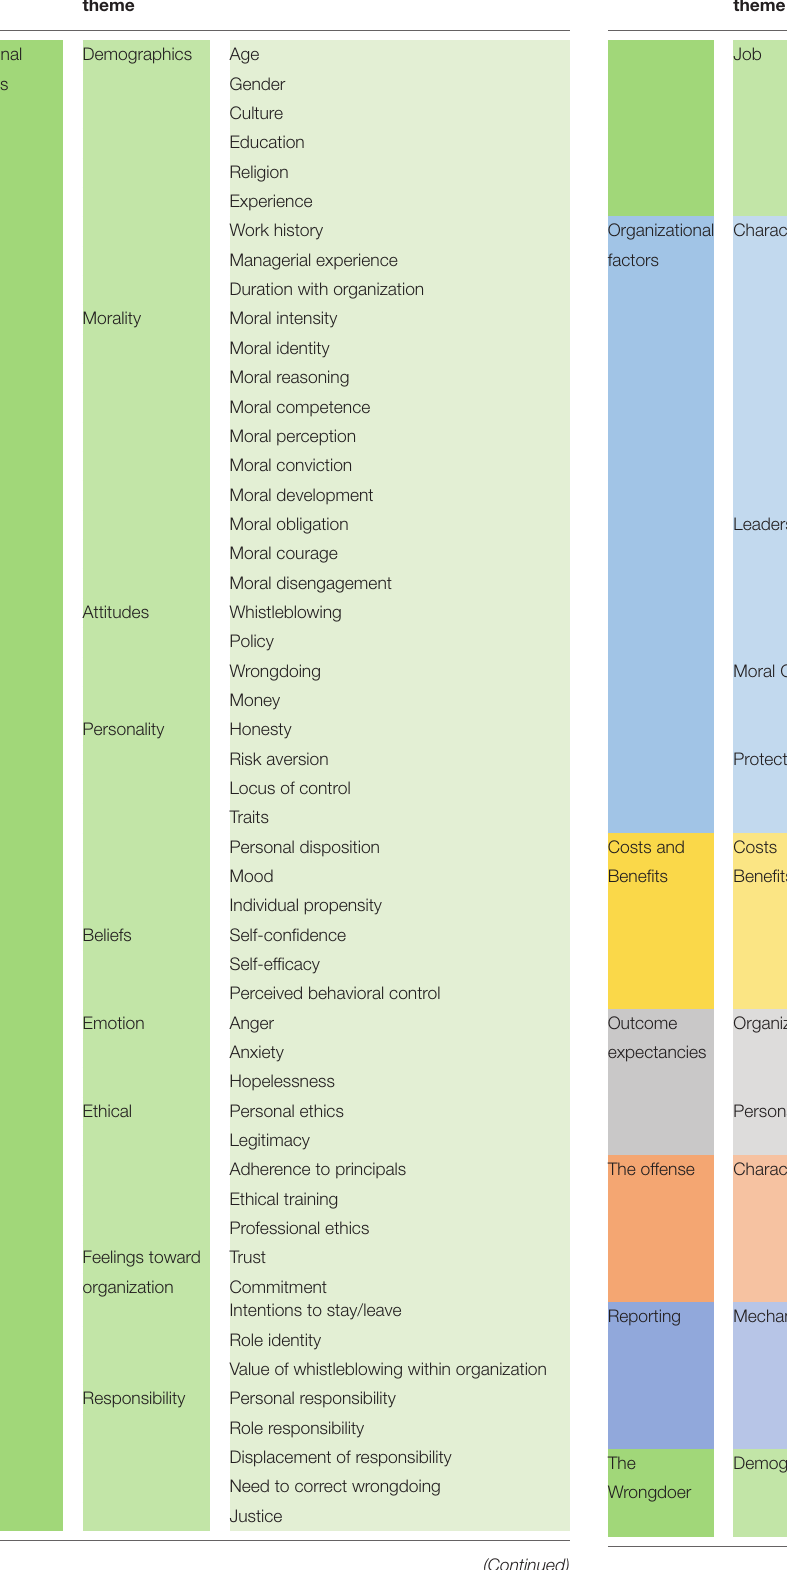
TABLE 1 | Dimensions, higher order, and lower order themes. Dimension Higher-order Lower-order theme theme Personal